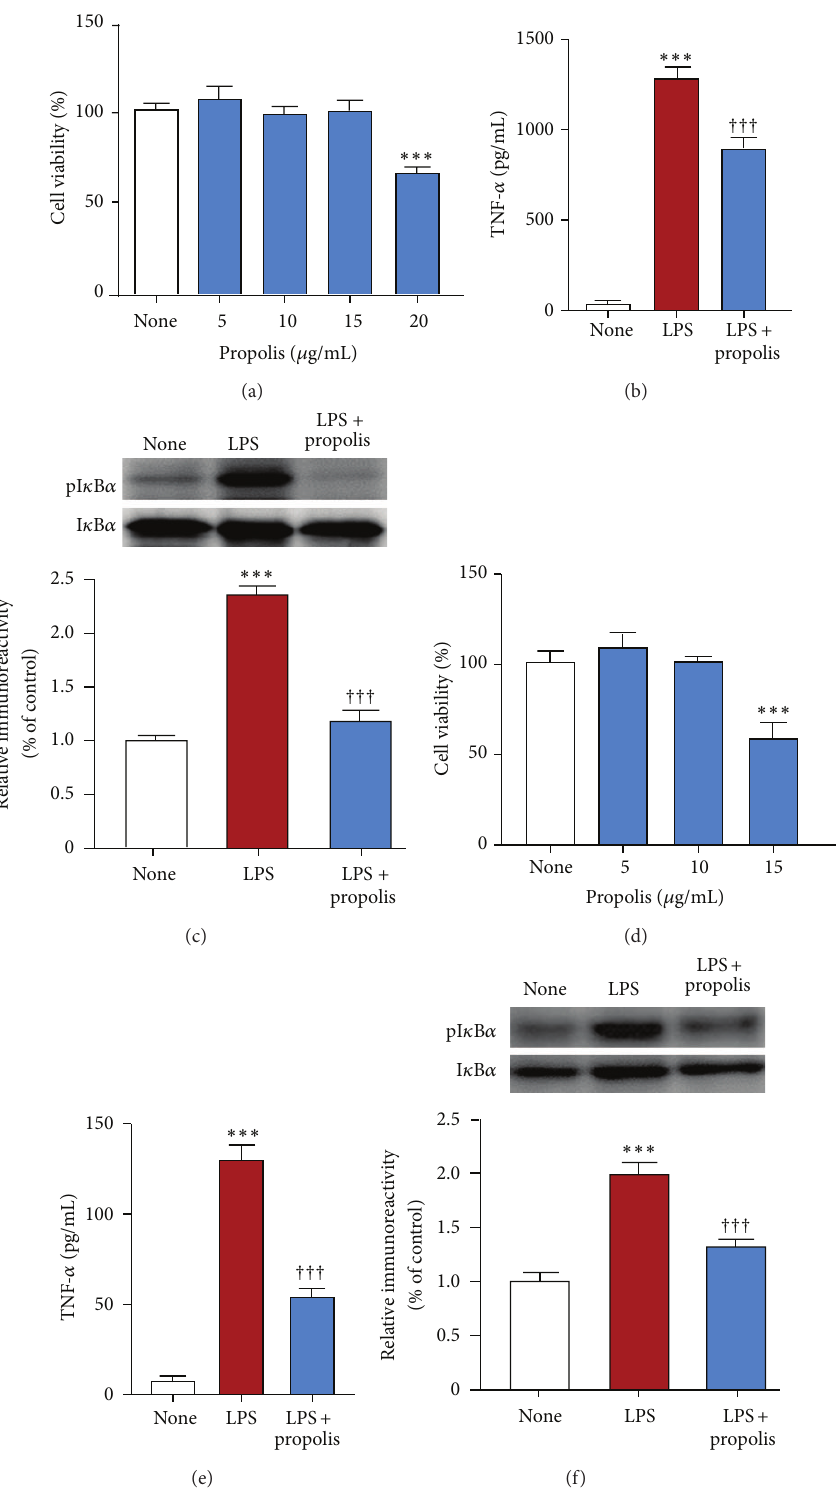
Figure 4: Effect of propolis on P.g. LPS-induced proinflammatory phenotypes of macrophages and leptomeningeal cells. Cell viability in RAW264.7 mouse macrophages (a) and in leptomeningeal cells (d) in the absence and presence of propolis with different concentrations for 48 h. Data are presented by mean ± SEM ( 𝑛 = 3 ), ∗∗∗ 𝑃 < 0.001 versus nontreated cells (none). TNF- 𝛼 release from P.g. LPS-treated RAW264.7 mouse macrophages with or without propolis (15 𝜇 g/mL) for 48 h (b), and leptomeningeal cells with or without propolis (10 𝜇 g/mL) for 6h (e) were measured by ELISA. Data are presented by mean ± SEM ( 𝑛 = 4 , each), ∗∗∗ 𝑃 < 0.001 versus nontreated cells (none), and ††† 𝑃 < 0.001 versus P.g. LPS alone. Phosphorylation of I 𝜅 B 𝛼 and the quantitative analyses of immunoblots in RAW264.7 mouse macrophages (c) and leptomeningeal cells (f) at 30 min after expose to P.g. LPS with or without propolis. Data are presented by mean ± SEM ( 𝑛 = 4 , each), ∗∗∗ 𝑃 < 0.001 versus nontreated cells (none), and ††† 𝑃 < 0.001 versus P.g. LPS